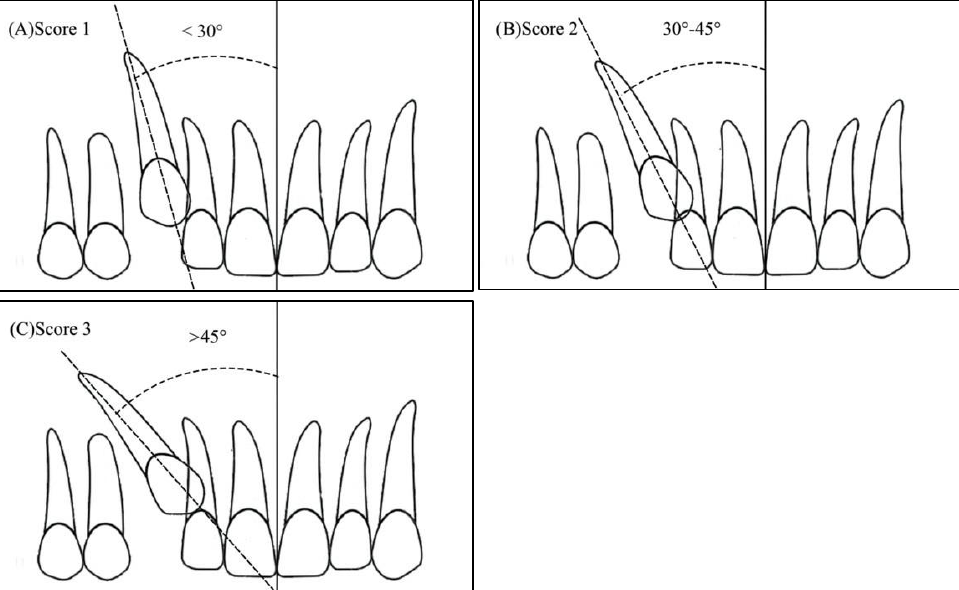
Figure 1. Angulation of the impacted canine to the midsagittal plane: ( A ) Score 1 — less than 30 degrees, ( B ) Score 2 — between 30 and 45 degrees, ( C ) Score 3 — more than 45 degrees.